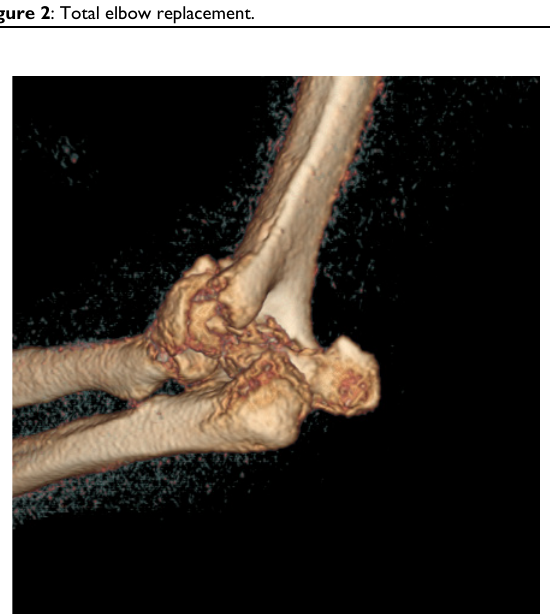
Figure 3 : 3D reconstruction shows AO type C3